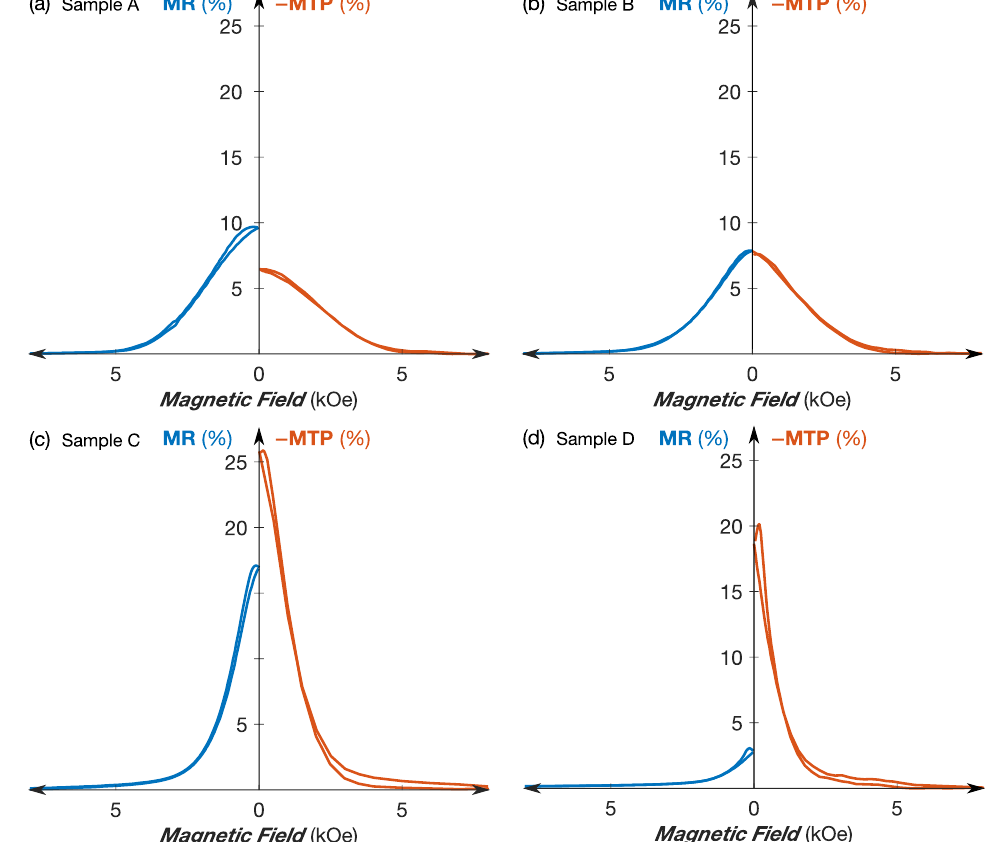
Figure 2. Room-temperature magnetoresistance (left side, in blue) and magneto-Seebeck (right side, in red) curves obtained by sweeping an external magnetic field along the in-plane direction of ( a ) Ni 60 Fe 40 /Cu (Sample A), ( b ) Ni 70 Fe 30 /Cu (Sample B), ( c ) Ni 80 Fe 20 /Cu (Sample C), and ( d ) Ni 97 Fe 3 /Cu (Sample D) NW